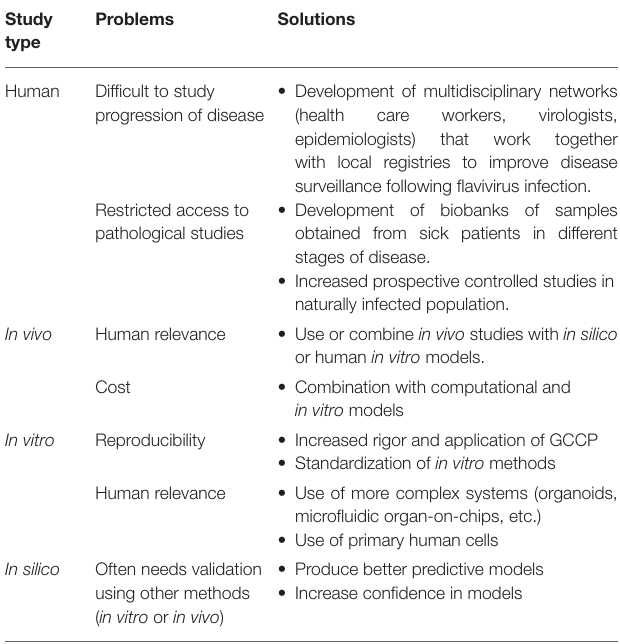
TABLE 2 | Problems and possible solutions for MBF